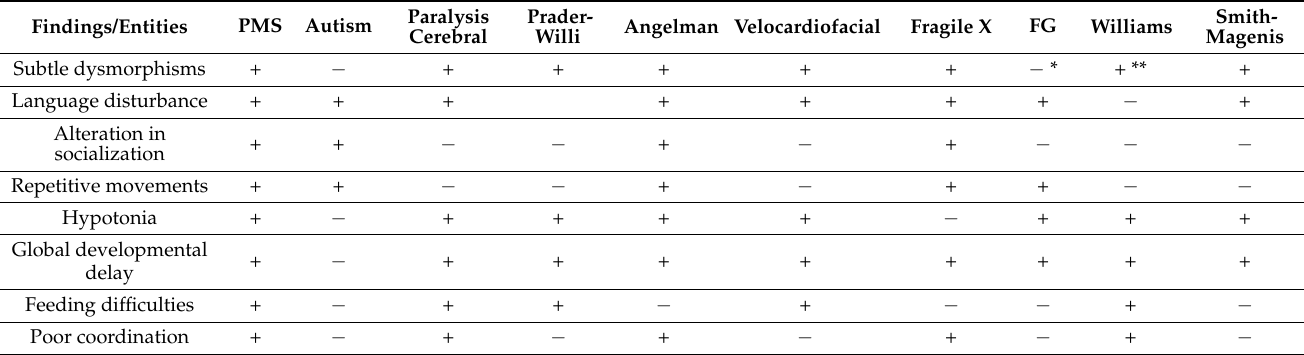
Table 3. Differential diagnosis of